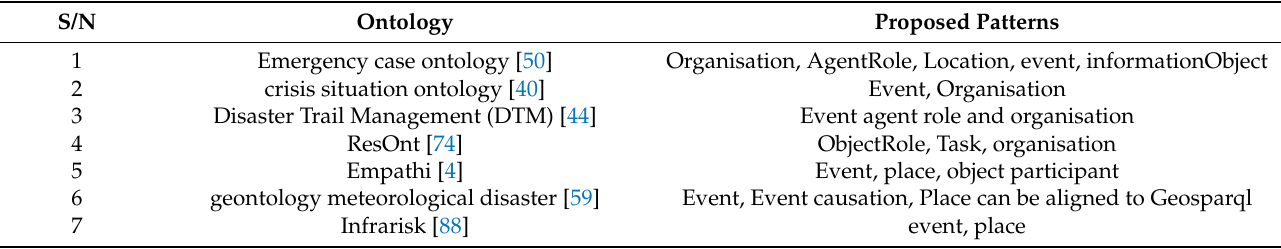
Table 10. Examples of Ontologies that can be Re-characterised by ODPs.